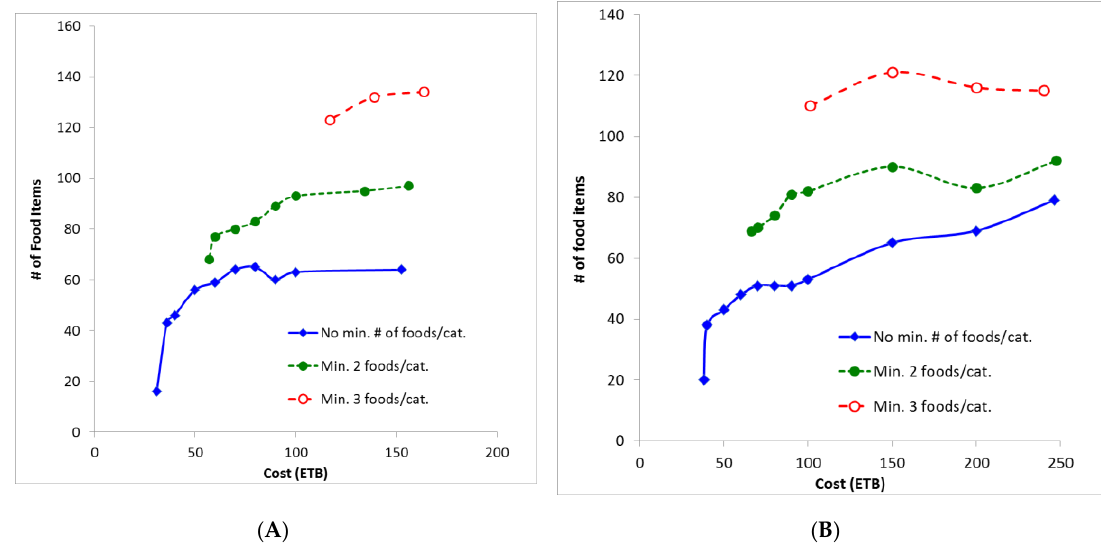
Figure 2. Number of foods contained in rural (Panel A ) and urban (Panel B ) food baskets depending on cost and minimum number of foods imposed per FBS food group [33]; ETB: Ethiopian Birr.